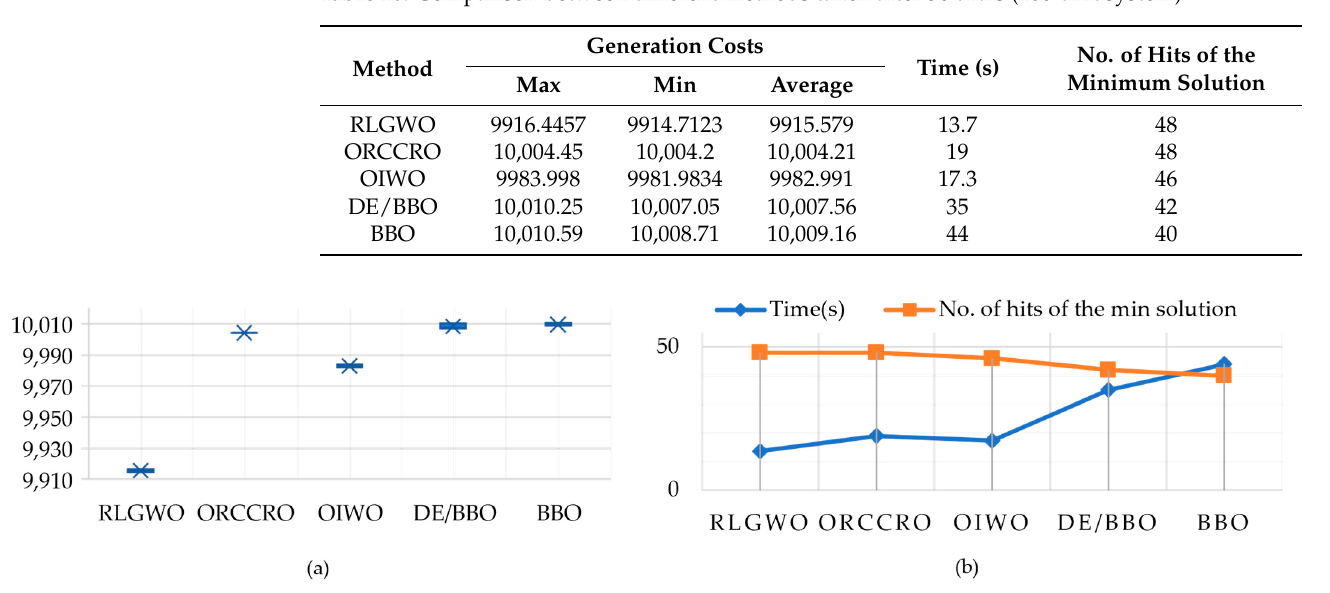
Figure 13. Results for different methods for the 160-unit system (50 trials): ( a ) boxplot of the final generation cost; ( b ) time and number of hits of the minimum solution.